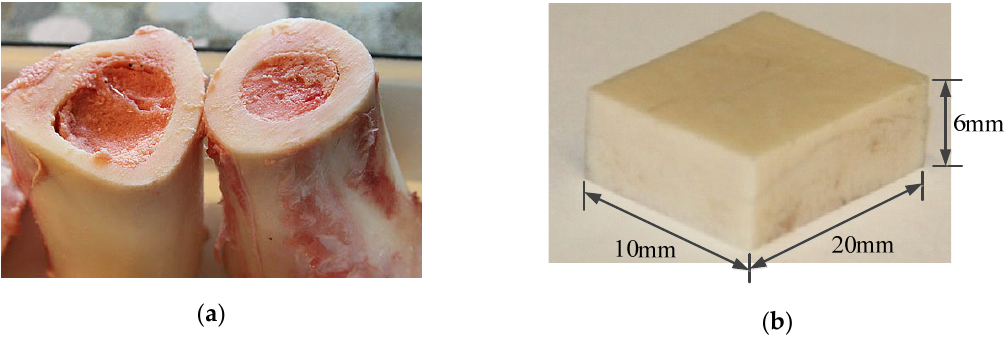
Figure 5. ( a ) Fresh bovine femur and ( b ) bone sample.